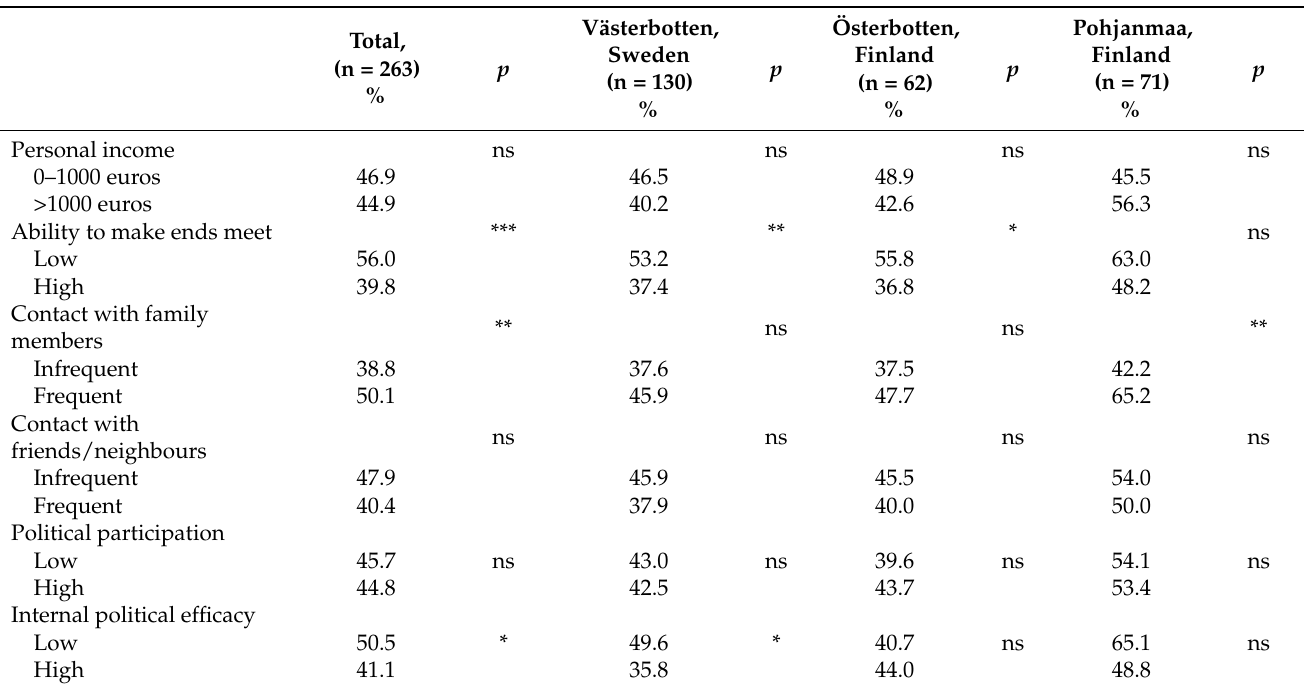
Table 2. Bivariate association between subjective caregiver burden and economic, social, and political resources among older spousal caregivers in Västerbotten (Sweden), Swedish-speaking Österbotten (Finland), and Finnish-speaking Pohjanmaa (Finland), respectively.